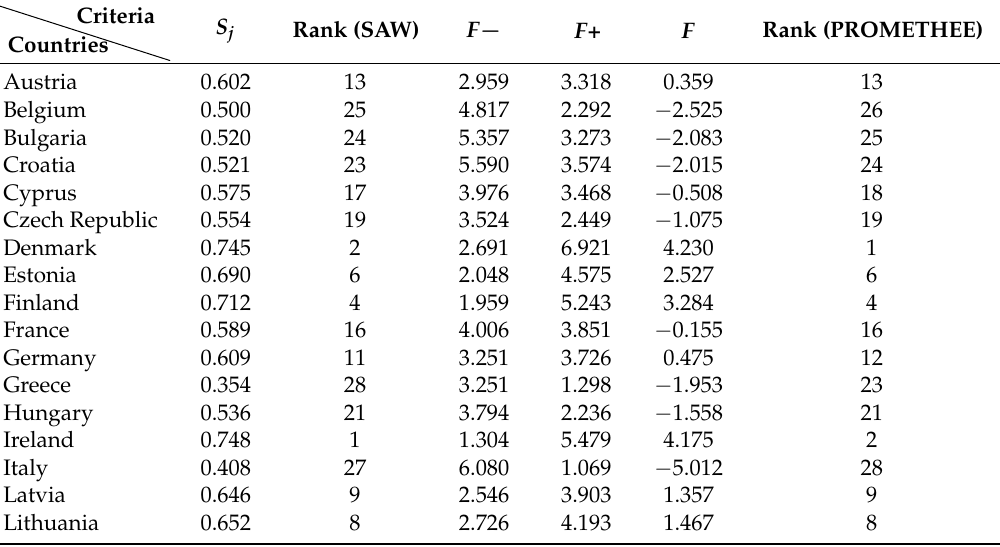
Table A1. Results of the evaluation of 28 EU countries by the SAW and the PROMETHEE II methods.